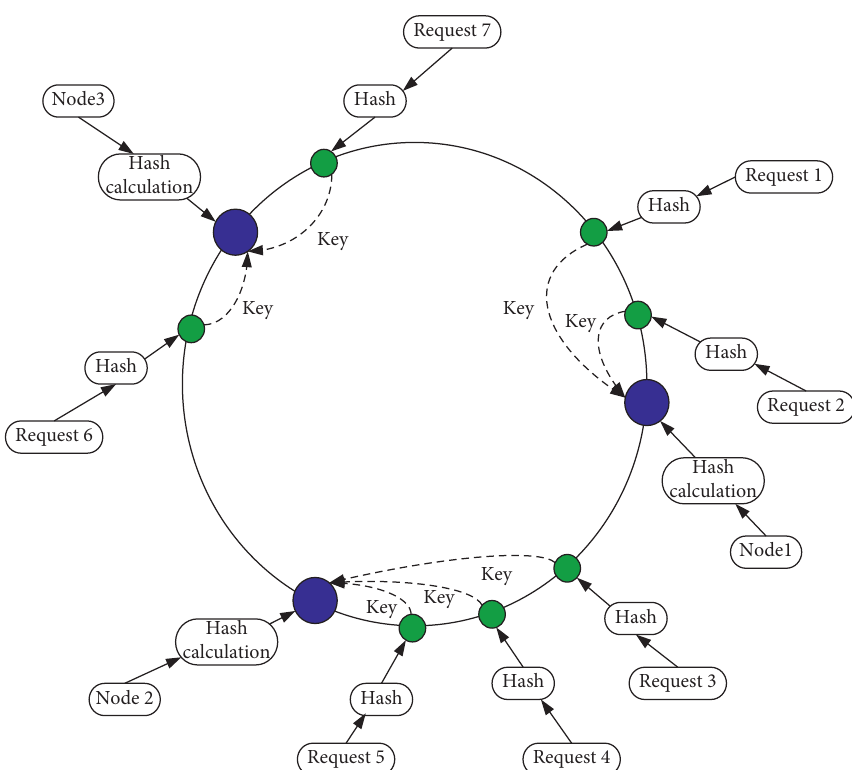
Figure 4: Cache node location relationship on the hash ring under CHL